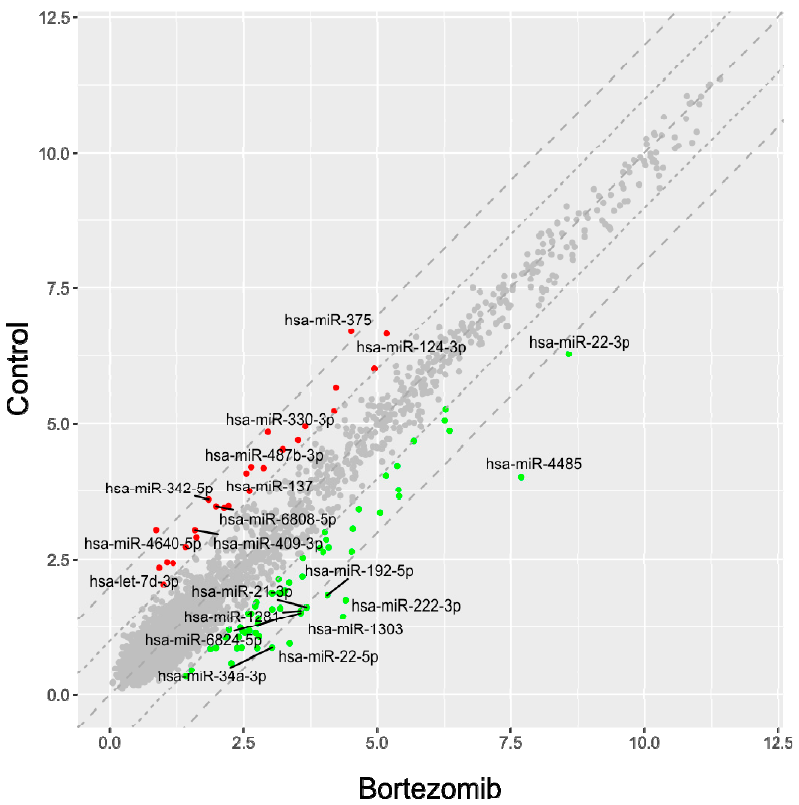
Figure 7. The scatterplot graph of global miRNAs expression in bortezomib-treated SH-SY5Y cells compared to the control cells. Red points show downregulated miRNAs (at least 2-fold change, p < 0.05), green points show upregulated miRNAs (at least 2-fold change, p < 0.05). The graph also comprises the names of miRNAs with the largest change in expression.